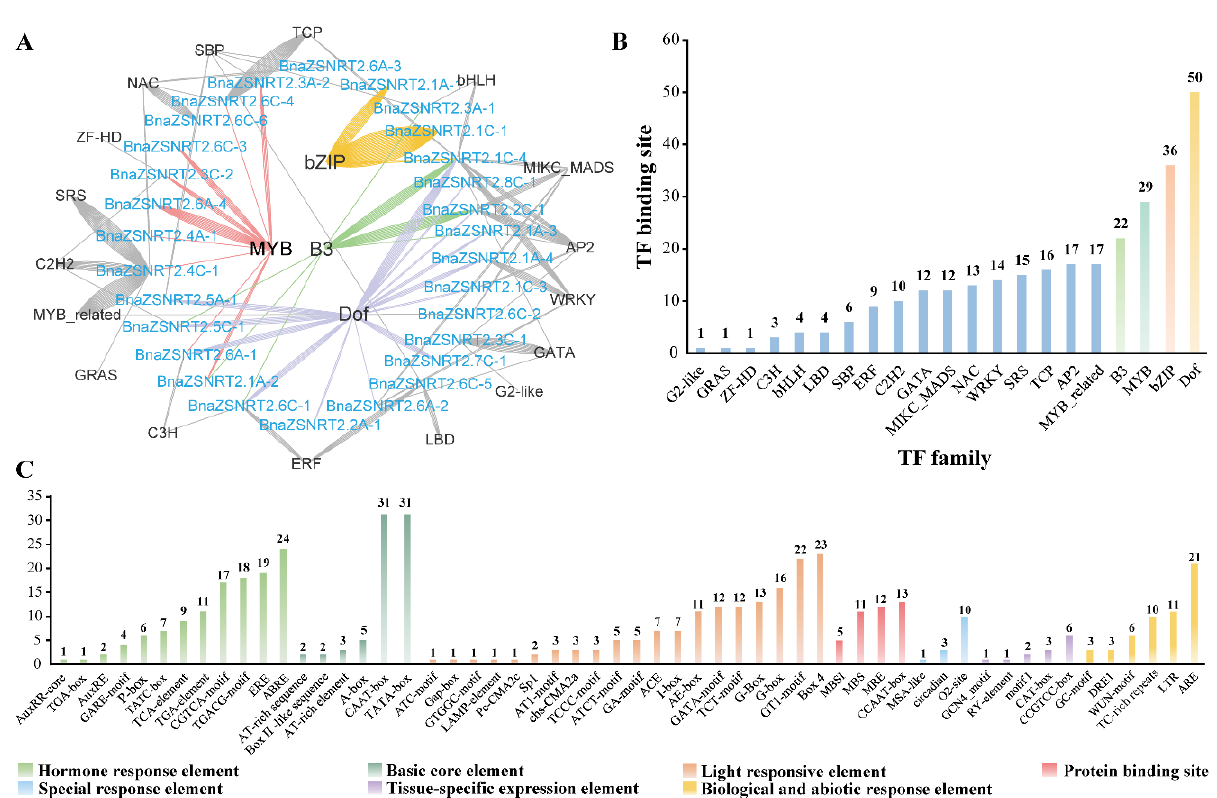
Figure 3. Transcription factor (TF) binding network and cis -element analysis in the promoter regions of BnaZSNRT2s . ( A ) The potential TF binding network of the 31 BnaZSNRT2s predicted by the PlantTFDB tool. ( B ) The TF gene families with potential binding sites in the promoter regions of the BnaZSNRT2s . ( C ) The cis -elements in the promoter regions of the BnaZSNRT2s . The ordinate represents the number of BnaZSNRT2s .